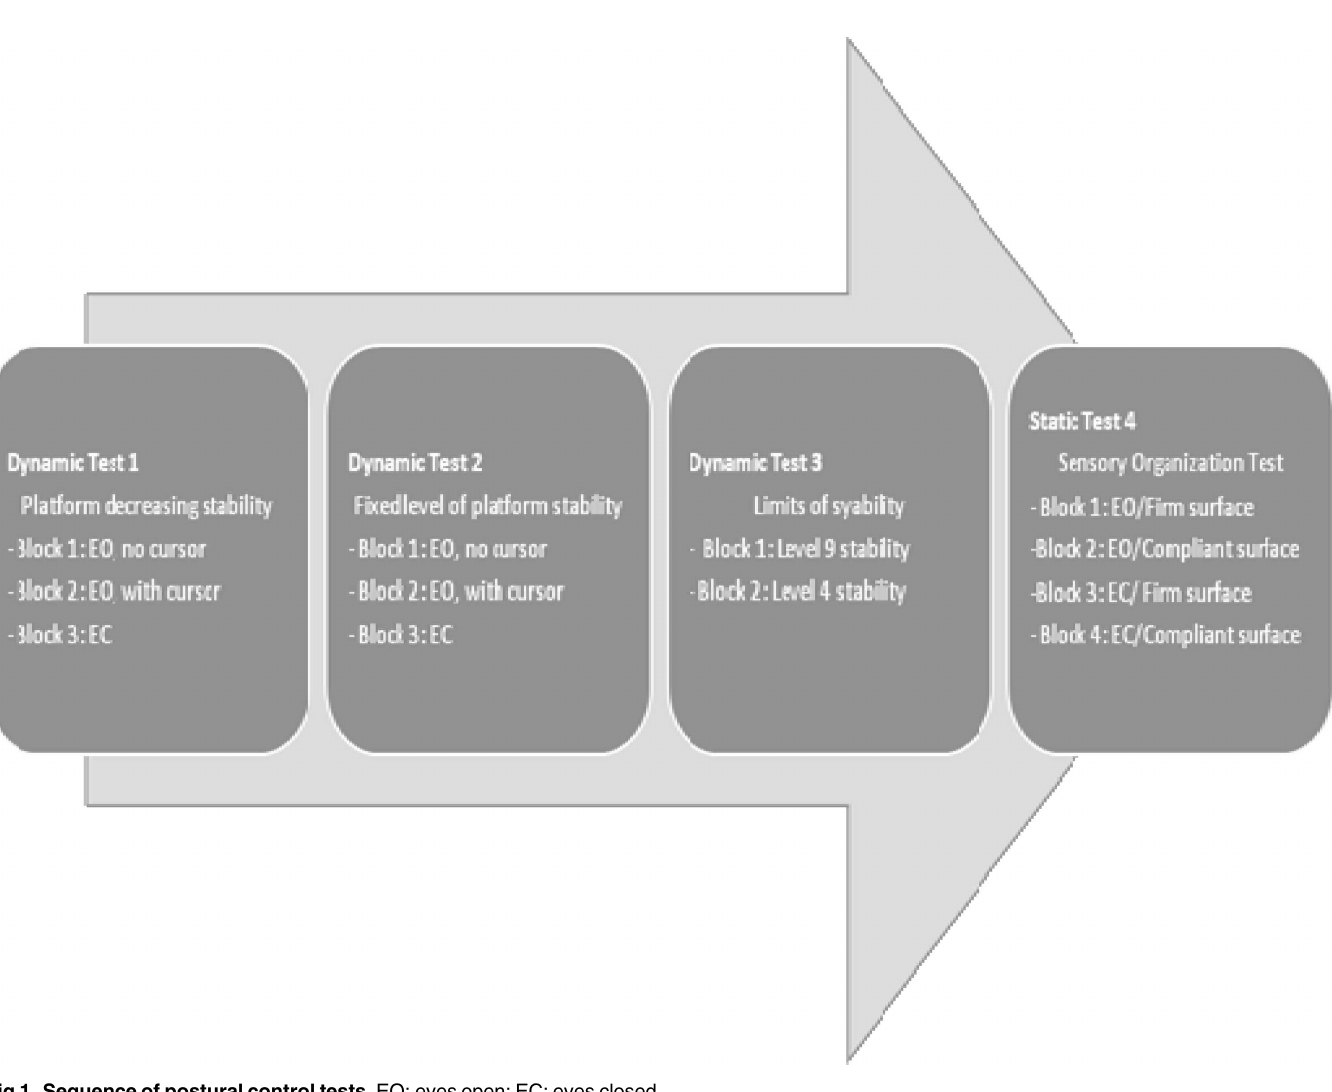
Fig 1. Sequence of postural control tests. EO: eyes open; EC: eyes